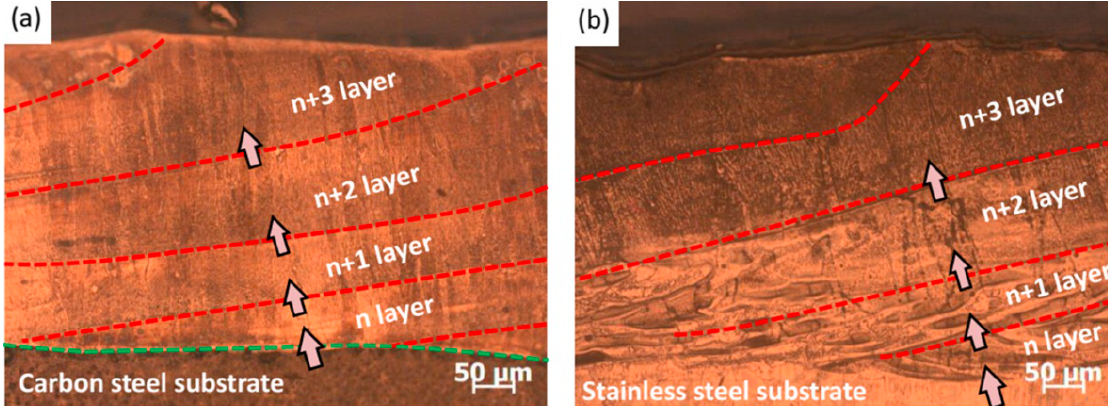
Figure 17. Microstructure of FeCoNiCrAl coating: ( a ) on carbon steel pipe, ( b ) on stainless steel pipe. Reprinted with permission from Ref. [92]. Copyright 2021 Elsevier.